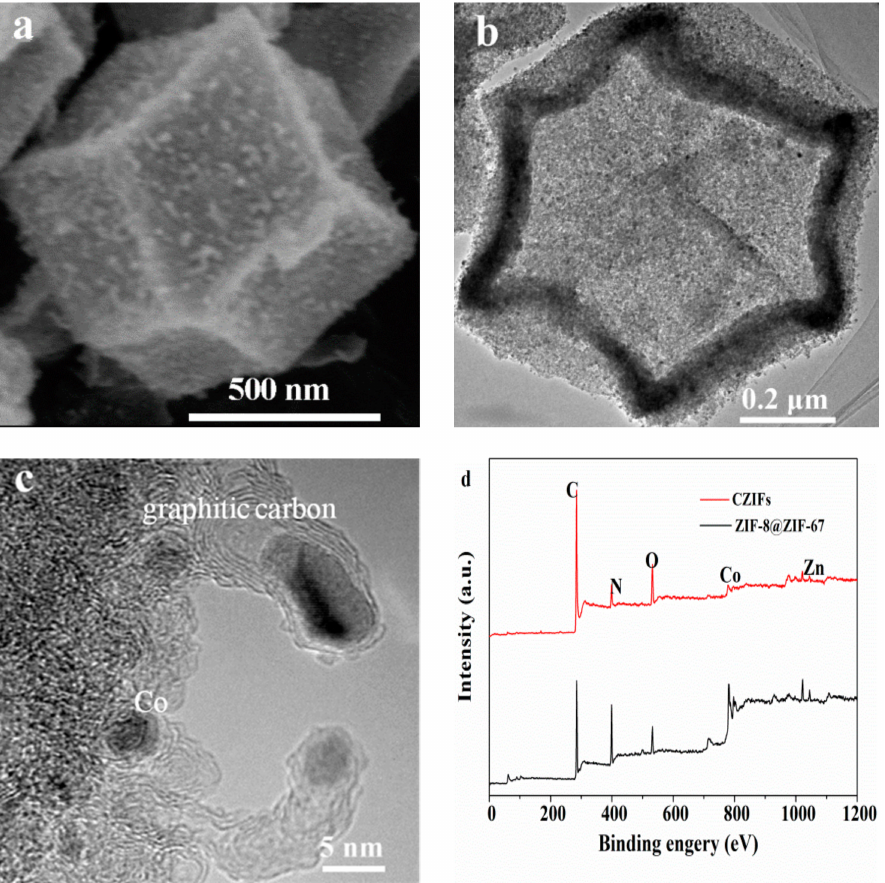
Figure 2. ( a ) SEM image and ( b , c ) TEM images of porous carbon, ( d ) XPS full scan of ZIF-8@ZIF-67 and